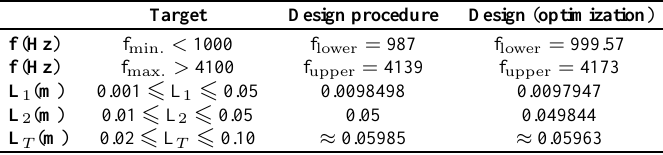
Table 5 Target, design and optimized values for example 3